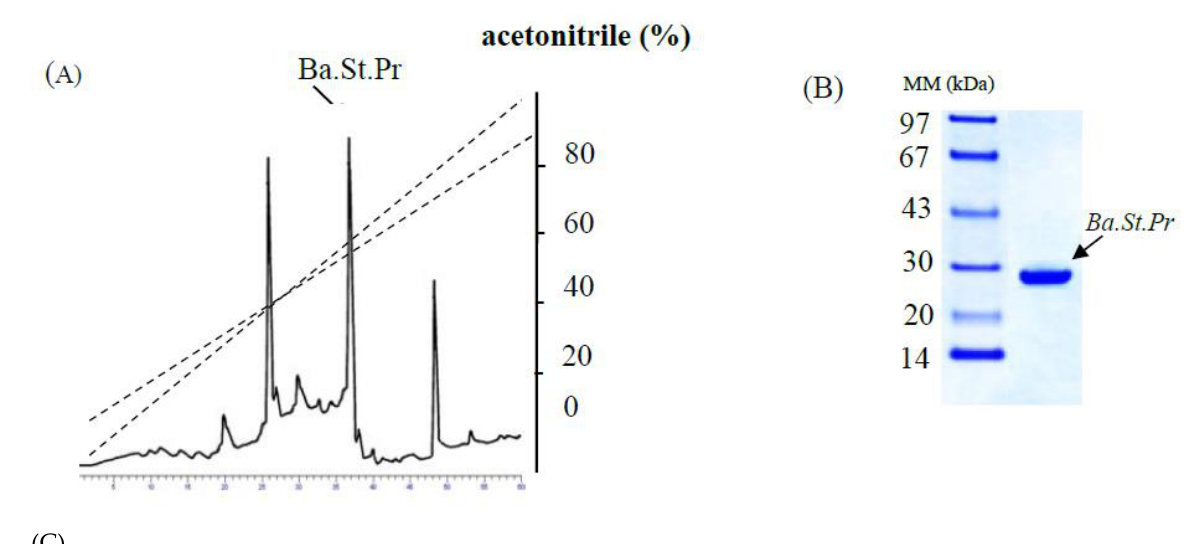
Figure 5. ( A ) Reversed-phase analytical HPLC on C8 matrix. Reversed-phase (RP)-HPLC eurospher 100, C-8 column (250 × 4.6 mm), was equilibrated in water. Protein elution was performed with an acetonitrile linear gradient (0–80%) at a flow rate of 1 mL/min over 60 min. 20 µL of protease (2 mg/mL). ( B ) SDS-PAGE of pure Ba.St.Pr (10 µg). ( C ) Local alignment of the Ba.St.Pr N-terminal sequence (present work) with the highest identity protease sequences from Bacillus strains. Identical amino acids in bold and different amino acids are in red.